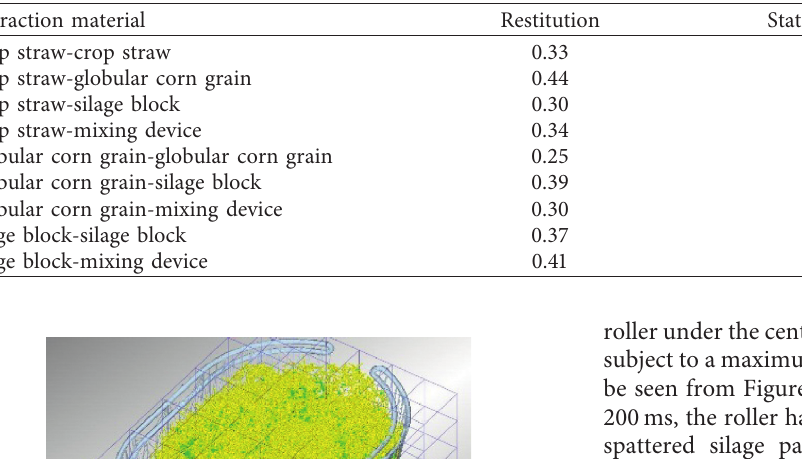
Table 2: Material contact property parameters used in the simulation.